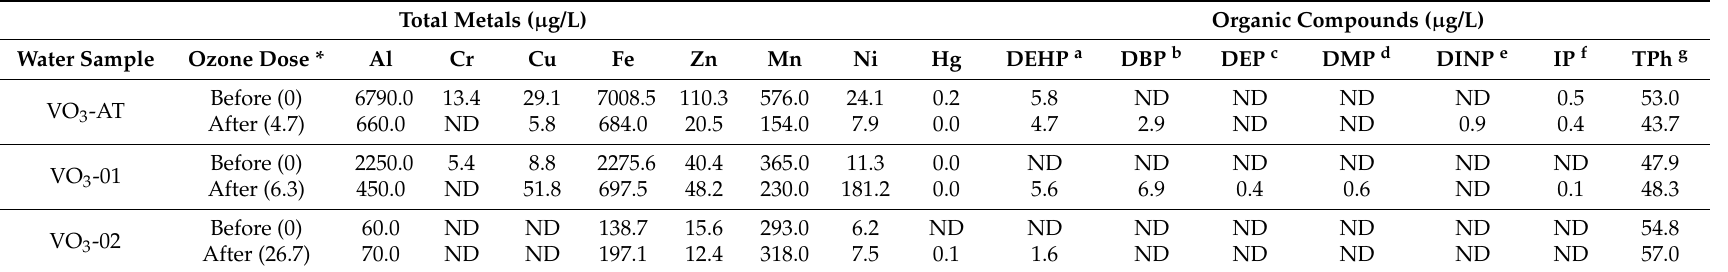
Table 5. Heavy metals and organic compounds in water samples before and after being treated with